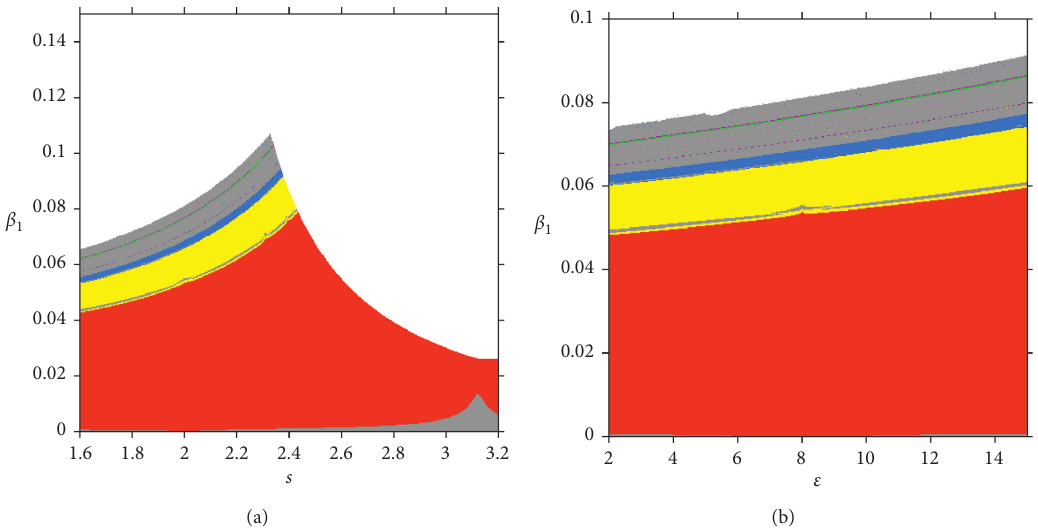
Figure 30: 2D bifurcation diagrams for periodic cycles. (a) 2D bifurcation with respect to β